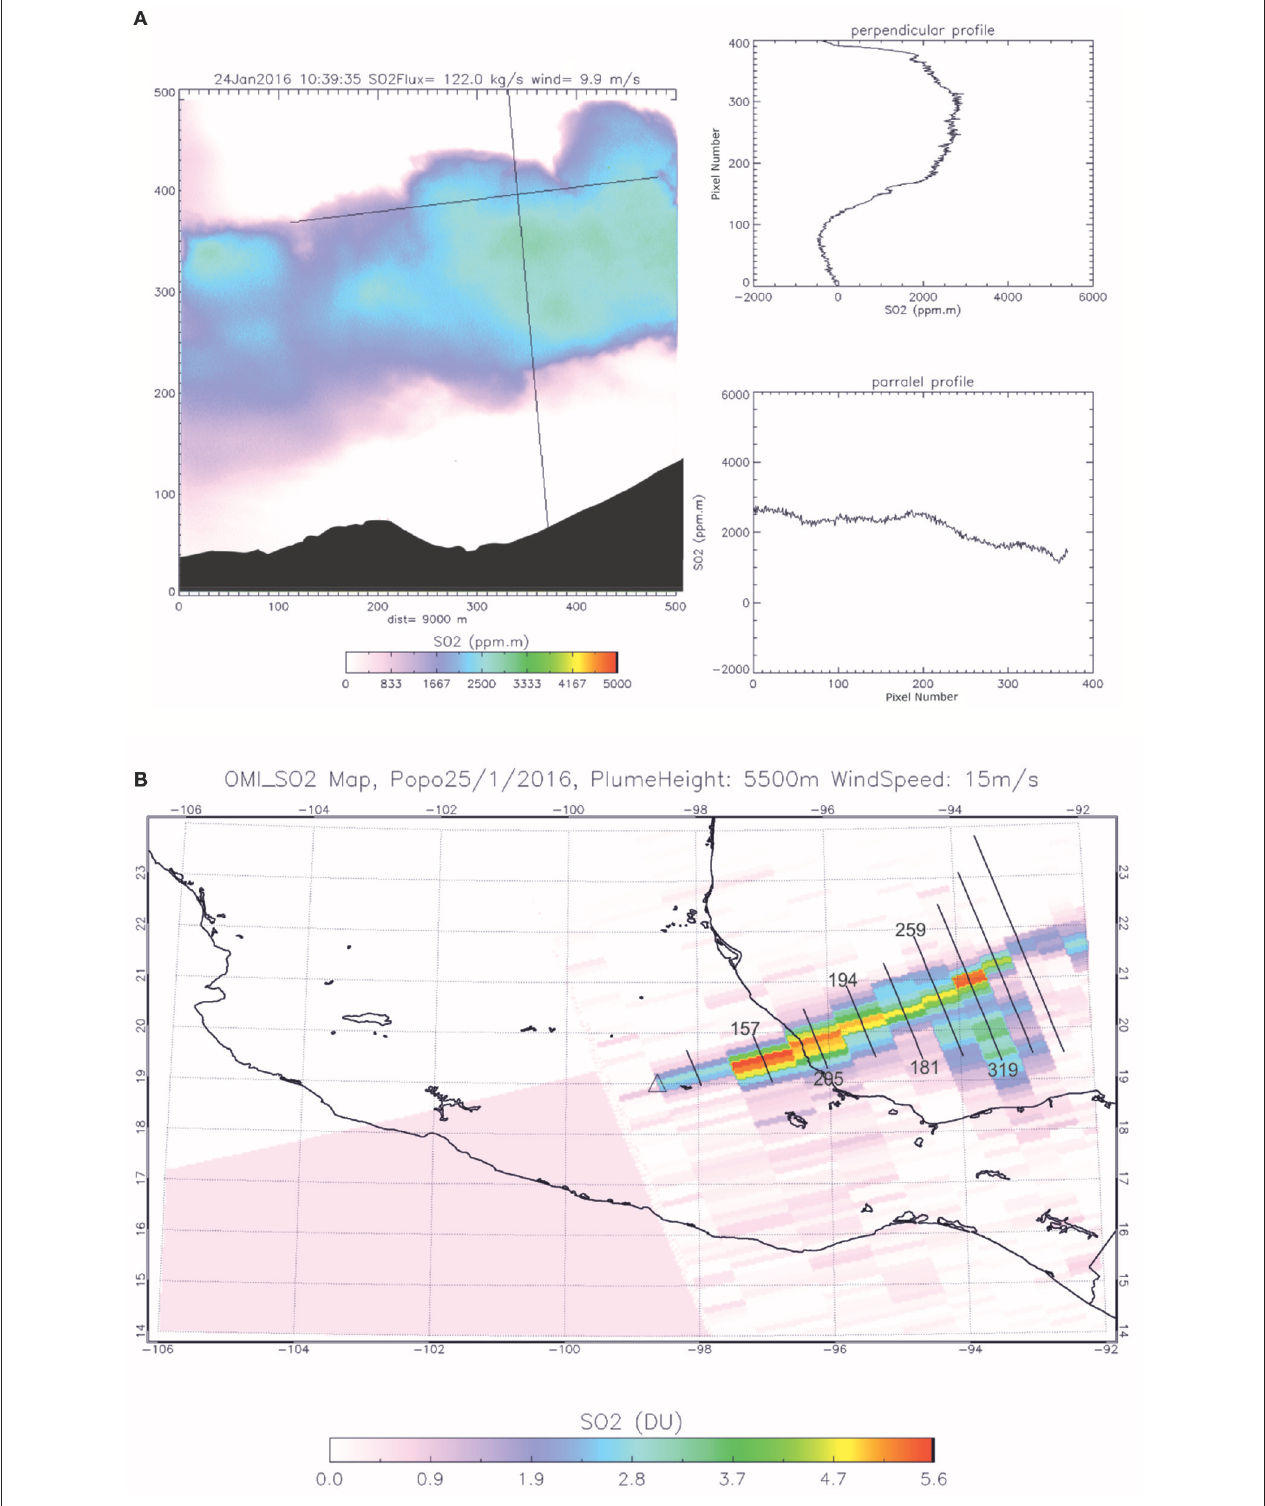
FIGURE 6 | Measurements of the SO 2 flux during an ash venting and dome growth episode. Measurements with the SO 2 camera (A) show an underestimation compared to measurements obtained by processing the OMI image of the following day (B) using the traverse method (Campion, 2014). The SO 2 flux, in kg/s, measured on each traverse downwind of the plume is annotated next to its corresponding traverse.